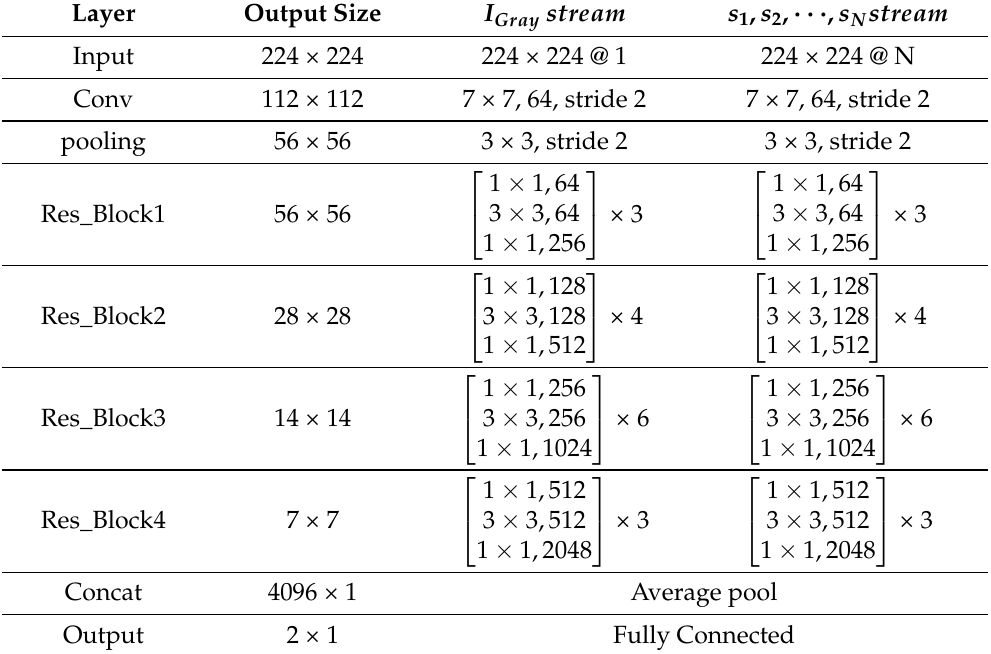
Table 1. Dual-stream network